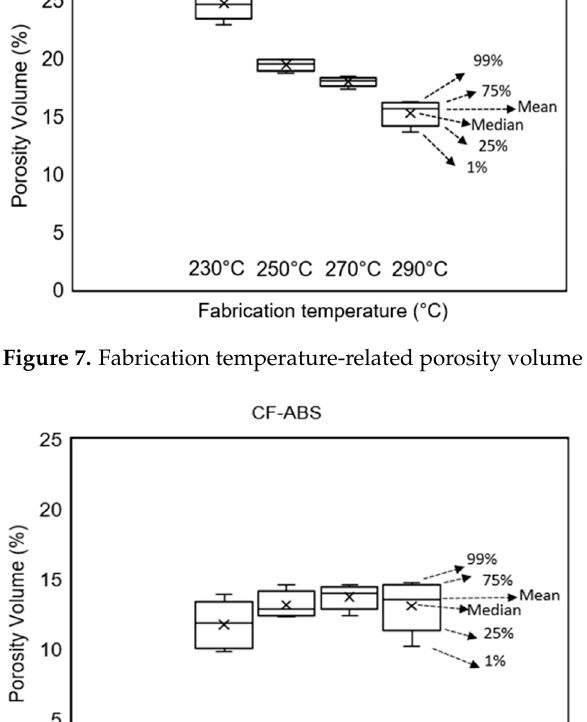
Figure 7. Fabrication temperature-related porosity volume in AM-fabricated CF-PA composite .